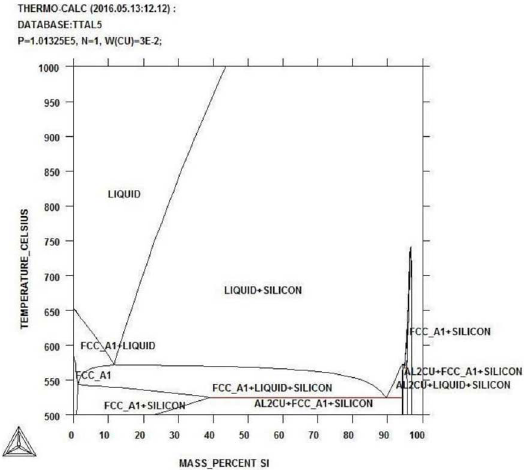
Figure 1. Partial phase diagram of the Al–Si-Cu system.